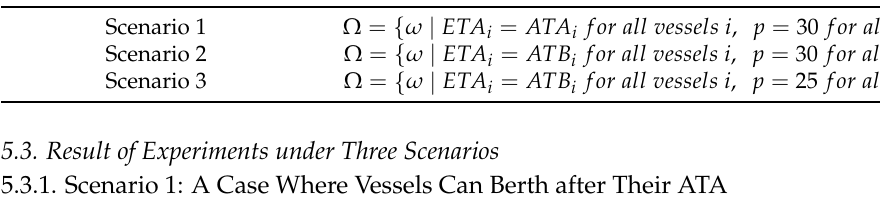
Table 1. Summary of the experiment